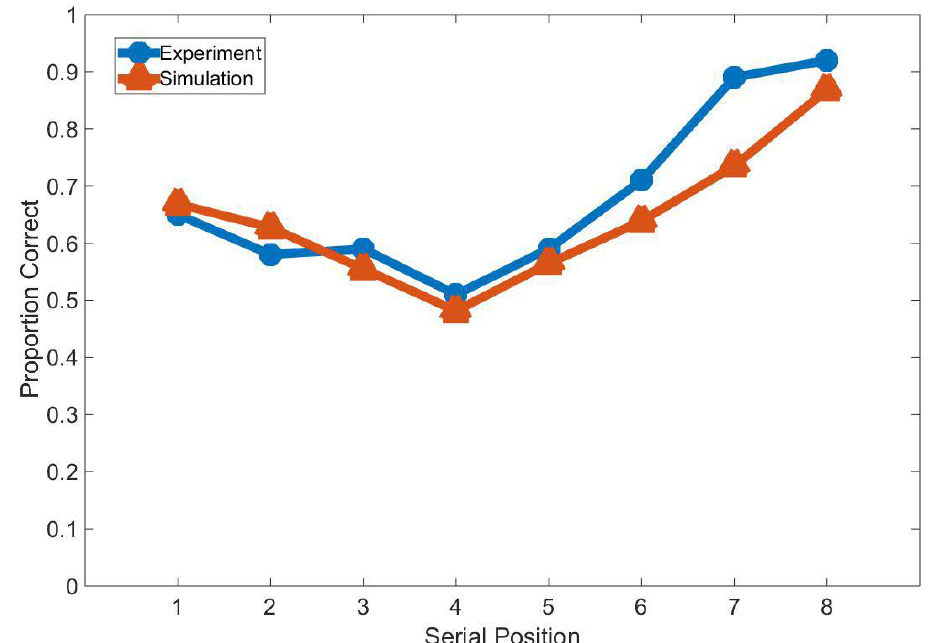
Figure 19. The results of Bhatarah et al.’s experiment and our model’s simulation